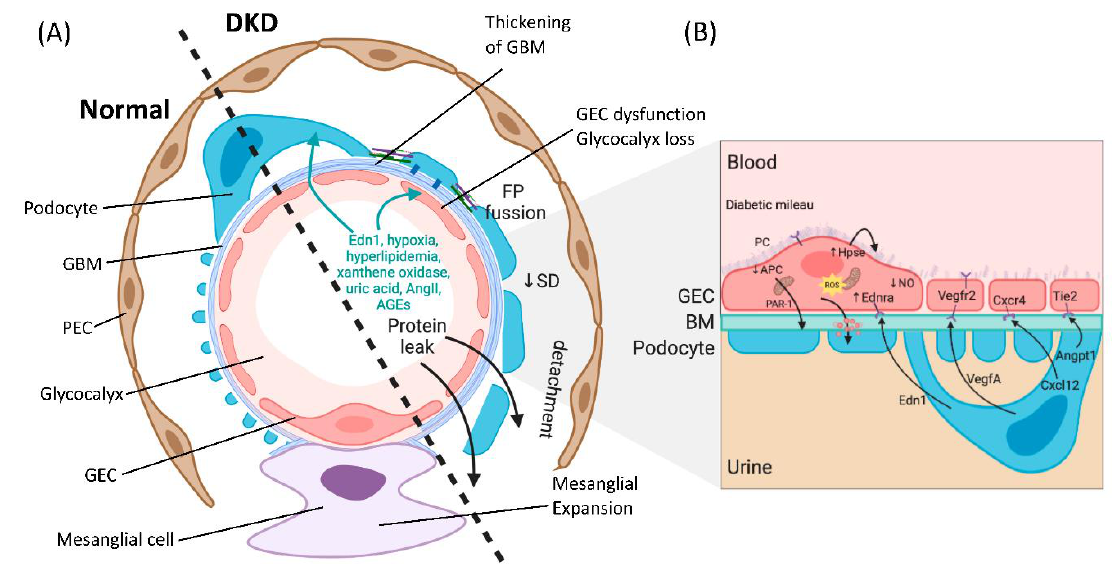
Figure 1. The glomerular filtration barrier. ( A ) Schematic showing a glomerular capillary loop that forms the primary filtering unit of the kidney, illustrating normal ( left ) and diabetic kidney disease (DKD) ( right ) morphology features. The glomerular capillary loop is comprised of specialized structures: parietal epithelial cells (PECs), the mesangial cells, visceral epithelial cells (podocytes) with interdigitating foot processes (FP) attached to the glomerular basement membrane (GBM), fenestrated glomerular endothelial cells (GEC), and the glycocalyx. Between podocyte foot processes is the slit diaphragm (SD), forming a bridge and tethering foot processes together. In DKD, there are profound morphological changes to the glomerulus, including thickening of the GBM, mesangial matrix expansion and increases in extracellular matrix deposition occluding its capillaries. Additional changes are GEC dysfunction, degradation of the glycocalyx, fusion of foot processes, disrupted architecture of the slit diaphragm, podocytes depletion and consequential protein leak. ( B ) There is disrupted bidirectional signaling among the cells in the filtration barrier in DKD, including increased podocyte-derived vascular endothelial growth factor a (VEGFA) in early DKD and decrease of VEGF in progressive disease. There is a loss of angiopoietin-1 (Angpt1) and tyrosine-protein kinase receptor (Tie2) interaction in diabetes, and production of activated protein C (APC) in the glomerulus is reduced because of suppression of thrombomodulin expression. Decreased functional activity of APC a ff ects the permeability of the glomerular capillary wall and enhances apoptosis of GECs and podocytes. Endothelin-1 (Edn1) and endothelin receptor A (Ednra) pathway activation in DKD lead to mitochondrial oxidative stress, endothelial nitric oxide (NO) depletion, and degradation of the endothelial